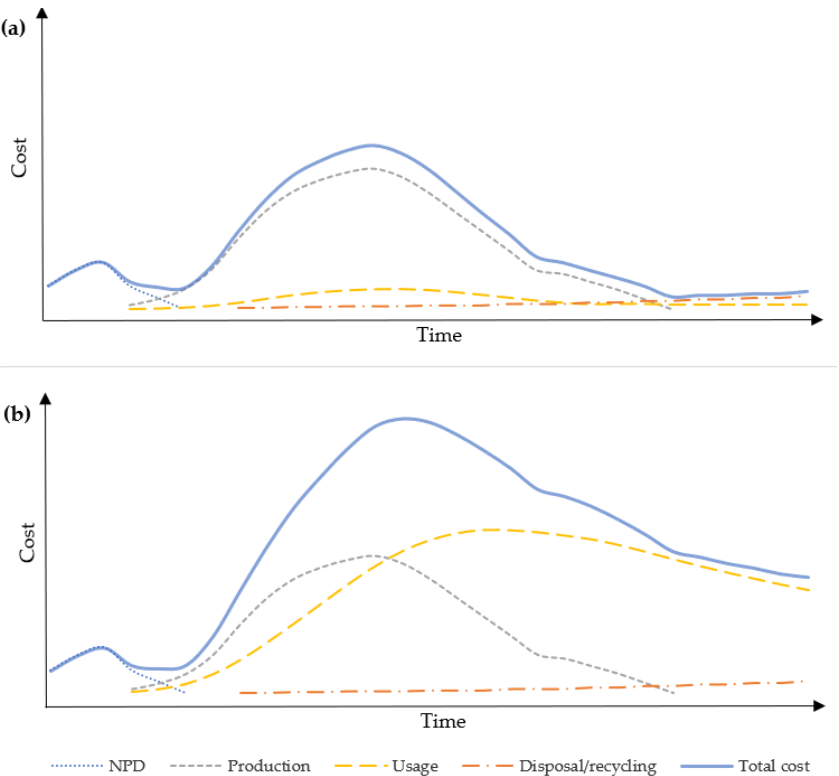
Figure 1. The product usage cost vs. the total product cost: ( a ) an example of a low-cost product usage; ( b ) an example of a high-cost product usage.